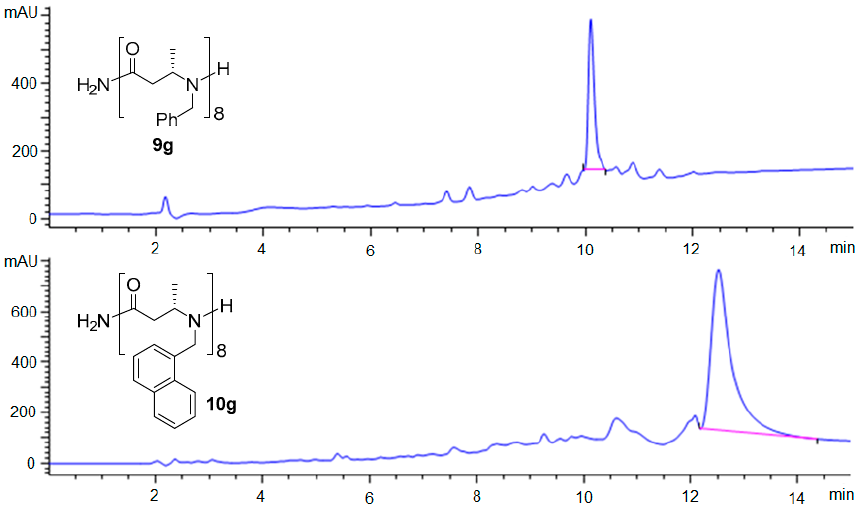
Figure 2. HPLC chromatograms of crude β -ABpeptoid oligomers 9g and 10g . Table 1. Structures and analytical data of synthesized ( S ) form of β -ABpeptoid oligomers.